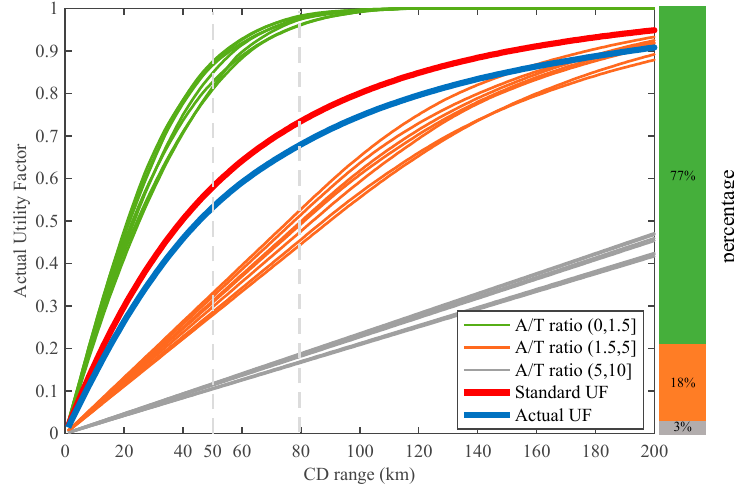
Figure 6. UF based on A/T ratio groups.